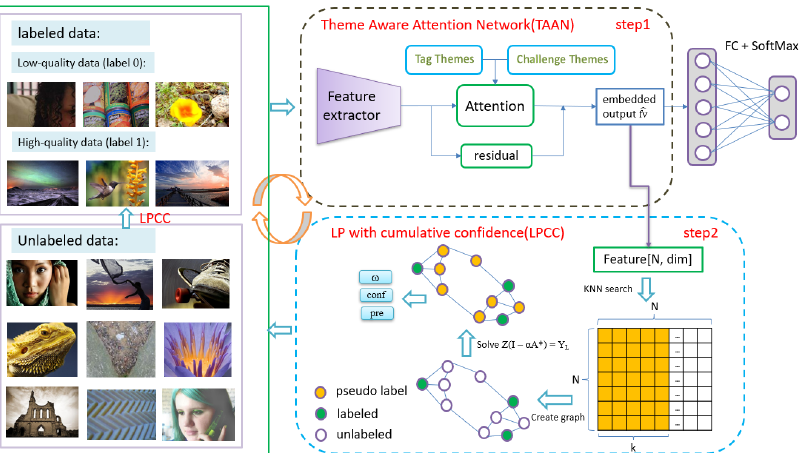
Figure 1. Overall architecture of our theme-aware semi-supervised image aesthetic quality assess- ment. First, in step one, we train our theme-aware attention network (TAAN) using a small amount of labeled data in a supervised fashion. In step 2, we use a label propagation with cumulative confidence algorithm (LPCC) to transduct the pseudo-labels for unlabeled data. We extract the features of the entire training set and compute a k-nearest neighbor graph. Then we propagate labels by transductive learning and train the theme-aware attention network (TAAN) on the entire training set. These two steps are iteratively trained. When testing, we send the input image directly into the trained TAAN model to obtain the predicted aesthetic quality. More detailed illustrations of label propagation with cumulative confidence algorithm (LPCC) can be found in Algorithm